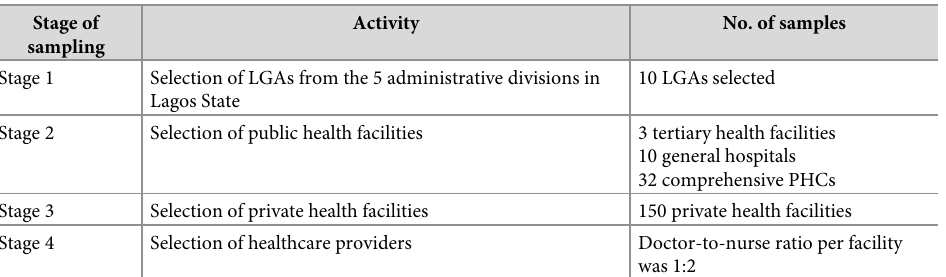
Table 1. Sampling